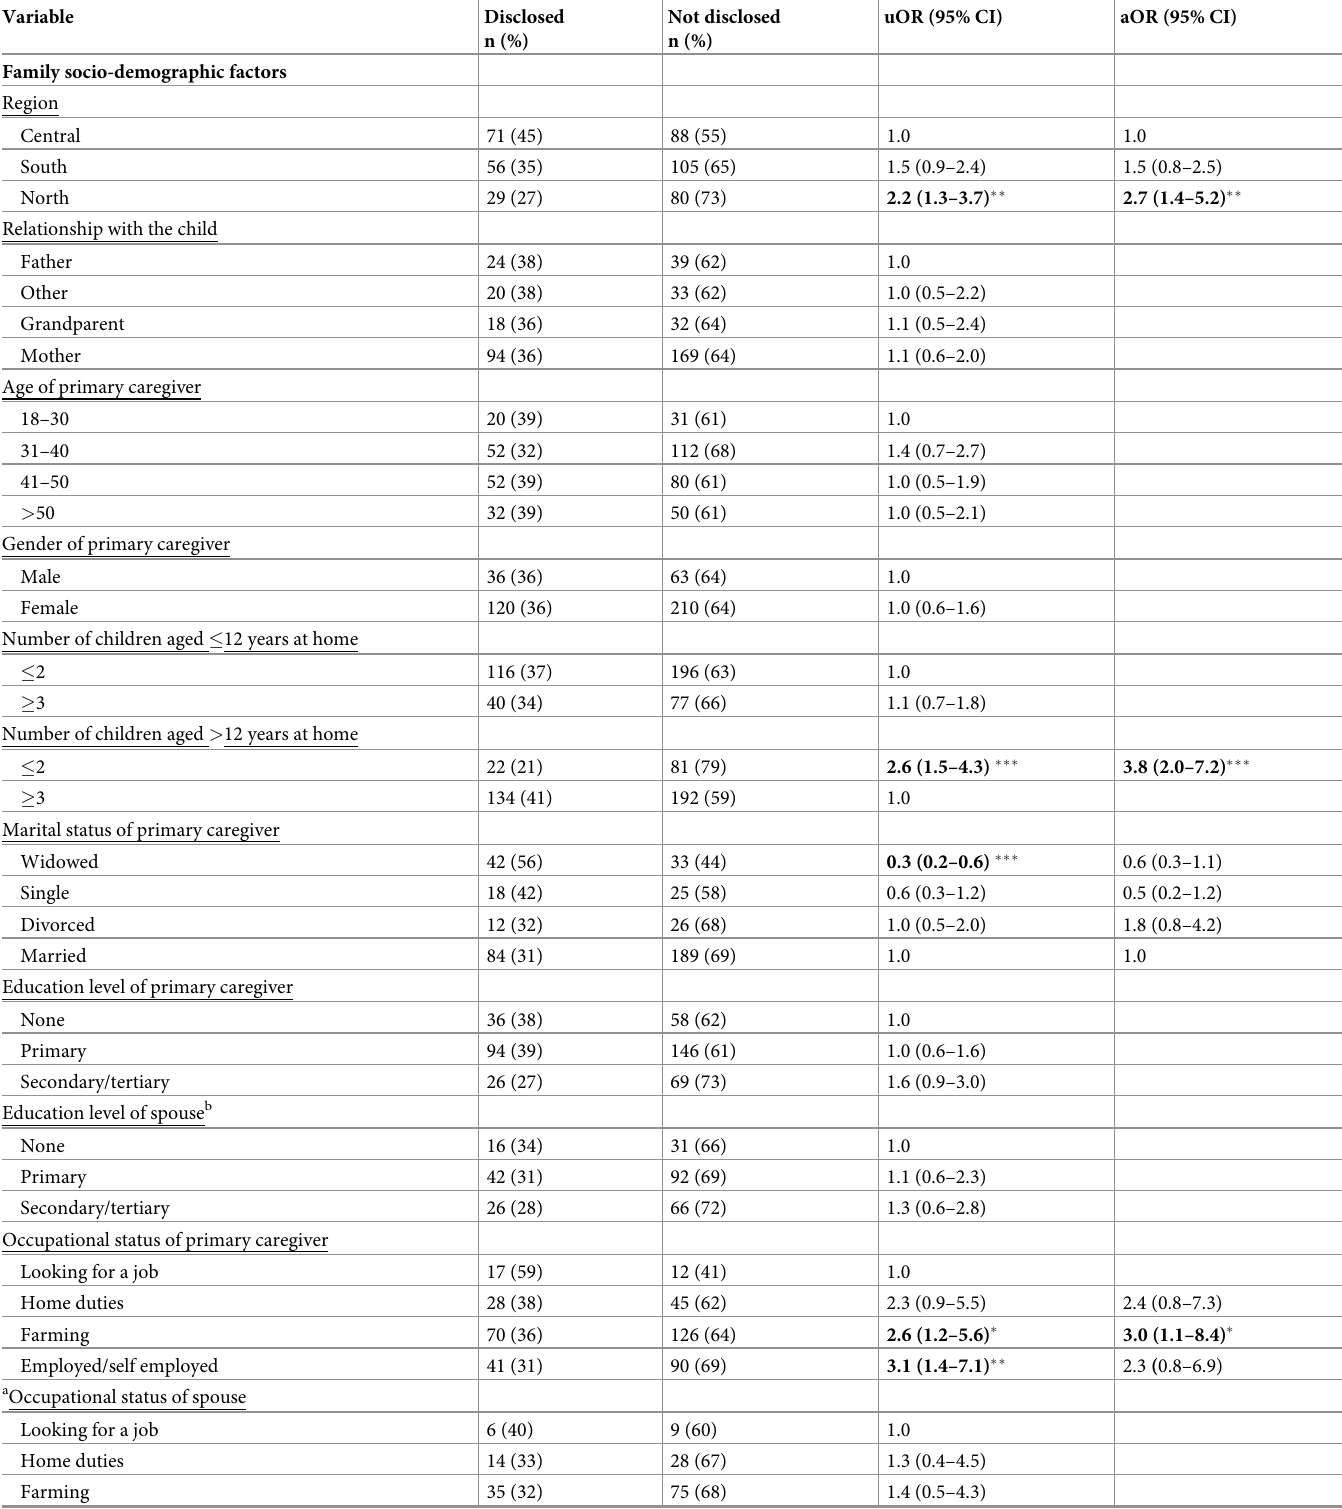
Table 4. Factors associated with non-disclosure of HIV status in bivariate and multivariate analysis (N =